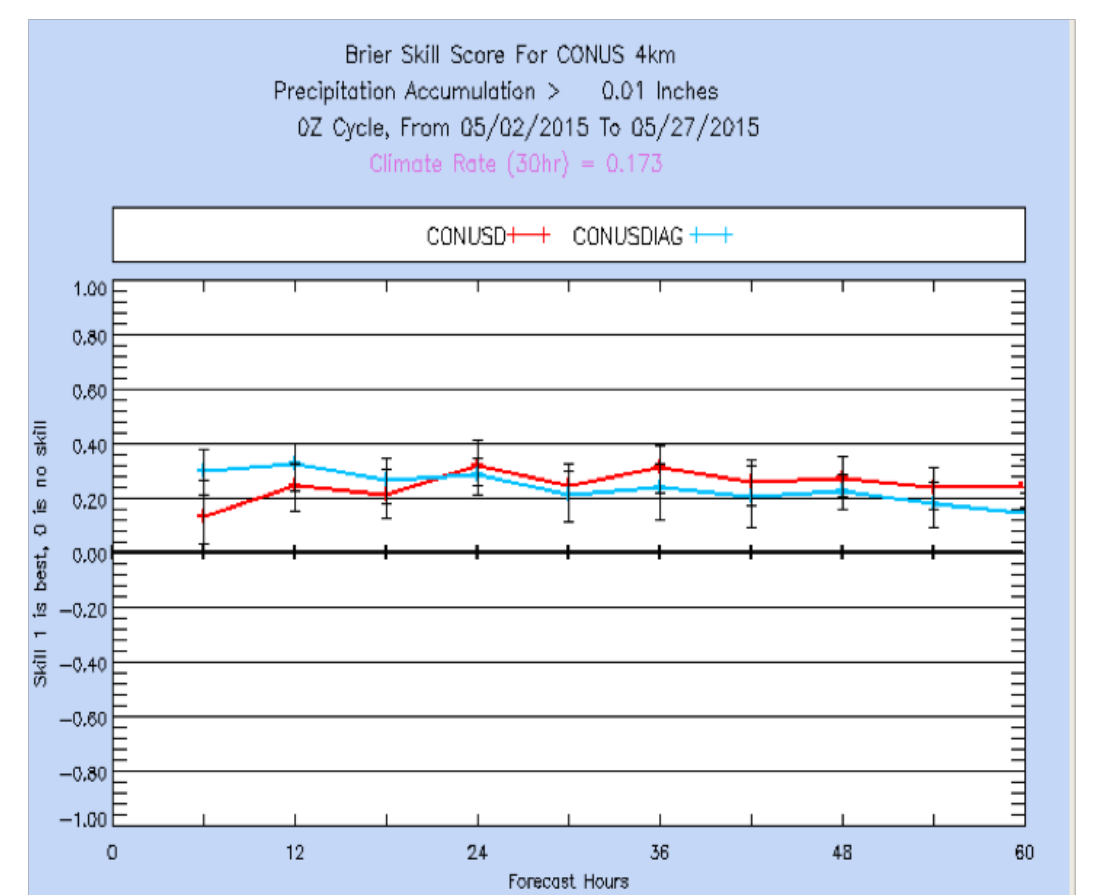
Figure 20. Brier skill score for precipitation exceeding 0.01 inches (0.254 mm) in six hours for the period 2-27 May 2015 for the operational (at that time) 4-km MEPS compared to precipitation observations in the US (CONUSD; in red) versus the “Rolling” ensemble (CONUSDIAG; in blue). Error bars represent the 95% confidence interval for the skill score.